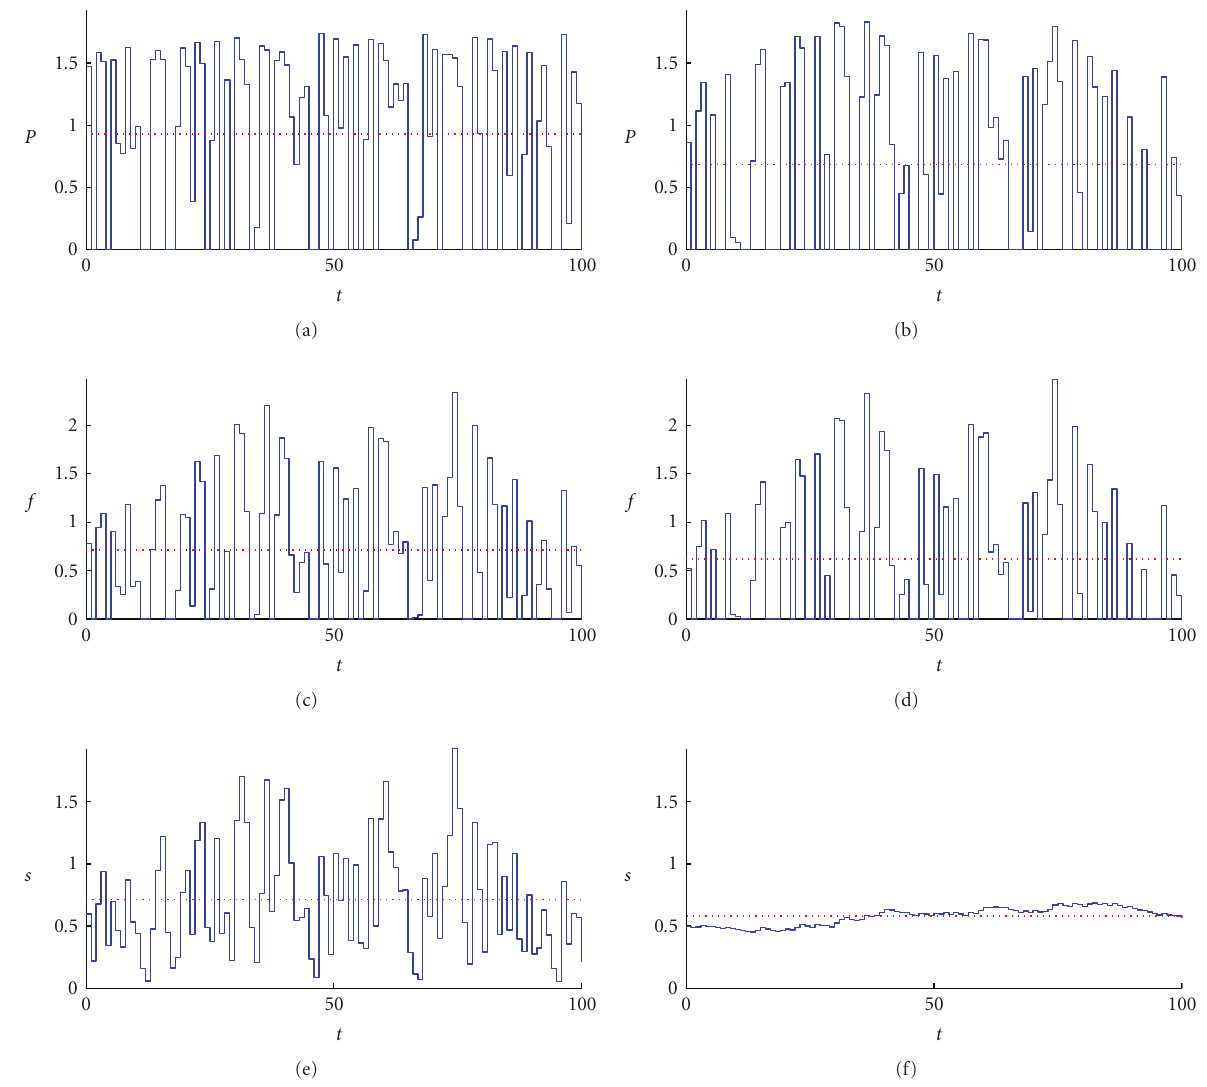
Figure 4: Sample power, flow, and smoothed flow trajectories; lightly smoothed flow (a, c, e), heavily smoothed flow (b, d,